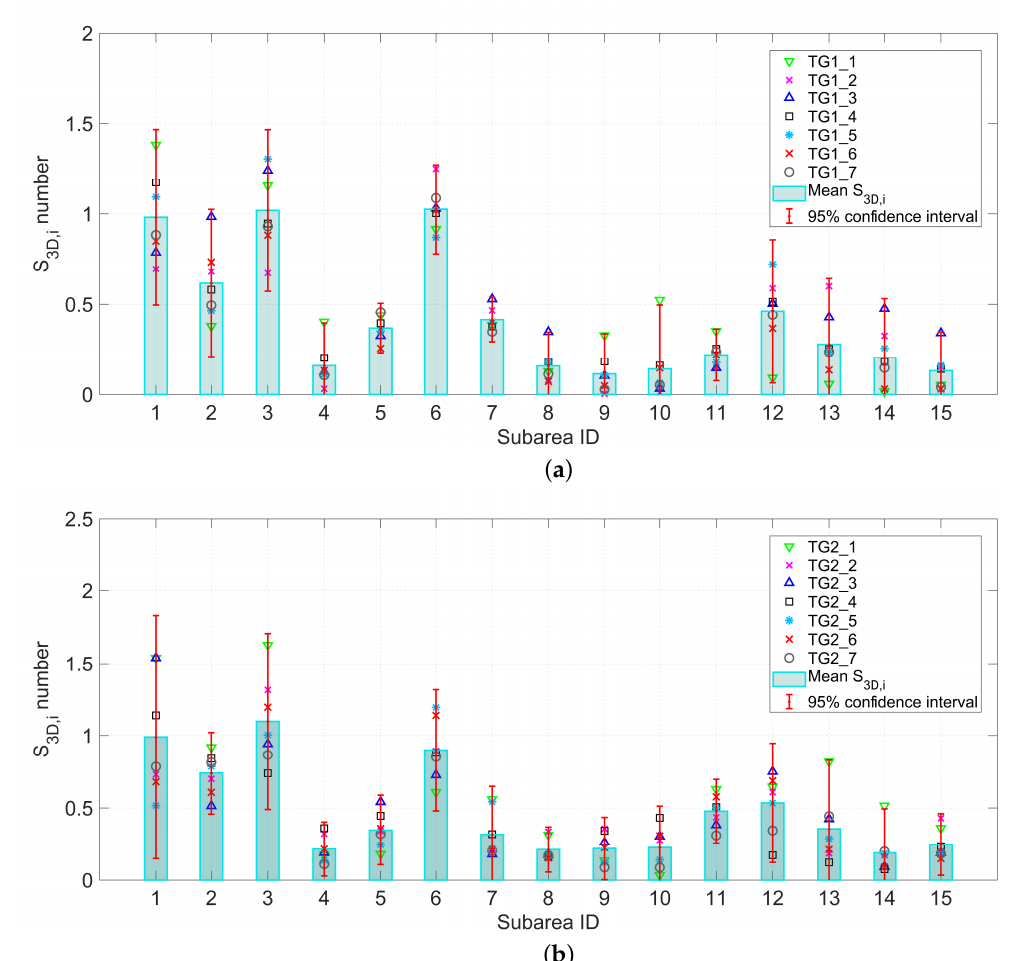
Figure 14. Damage numbers in each subarea along with the 95% confidence interval: ( a ) TG1; ( b ) TG2.